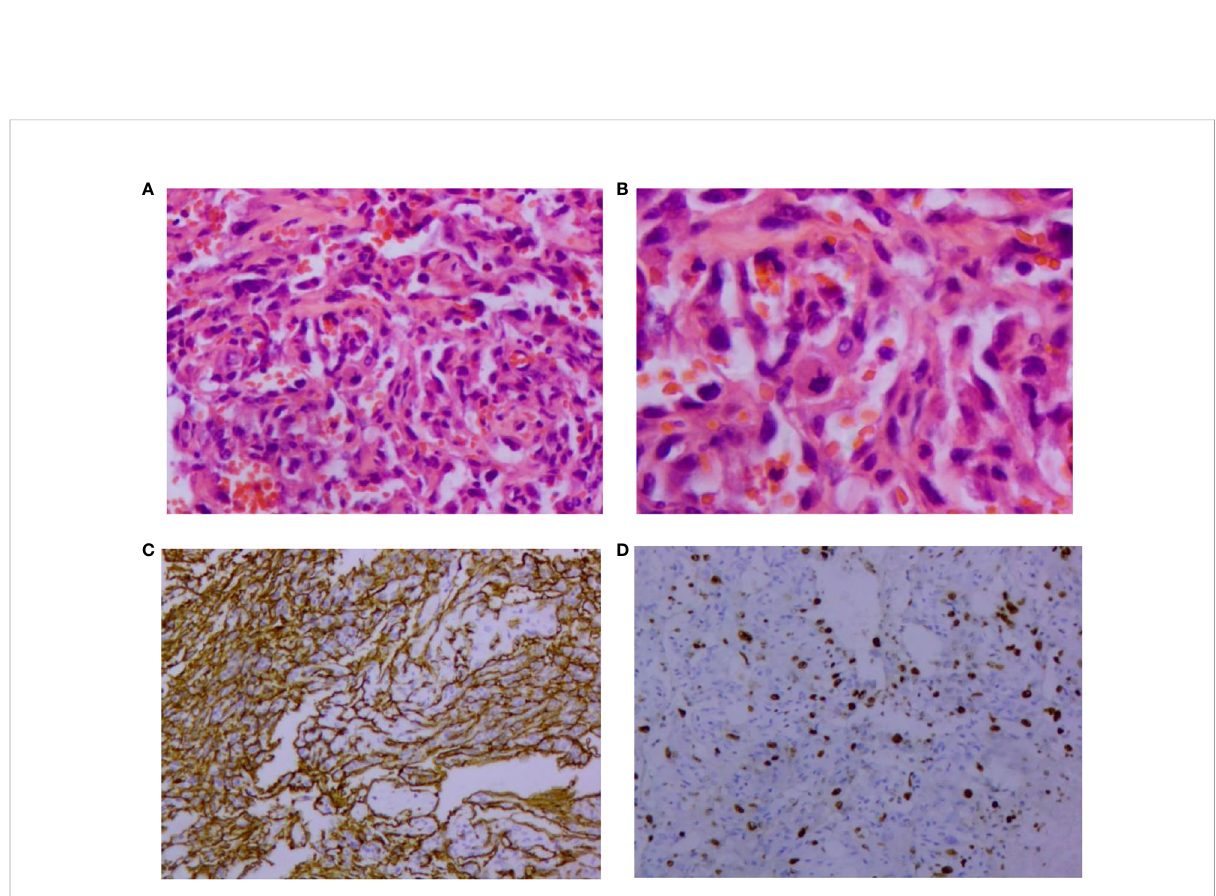
FIGURE 4 Pathological fi ndings of vascular neoplasms of the breast. (A) Formation of irregular and anastomosed vascular lumen lined with endothelial cells, large and hyperchromatic nuclei, and red blood cells in the lumen (HE, 200×); (B) Abnormal endothelial cells, which are round, ovoid, and spindle shaped. Nucleopathological mitosis was seen (HE, 400×). Immunohistochemical image of vascular neoplasms of the breast (SP, 100×); (C) Positive immunohistochemical staining for CD34; (D) Positive immunohistochemical staining of Ki-67. HE: Hematoxylin and eosin.